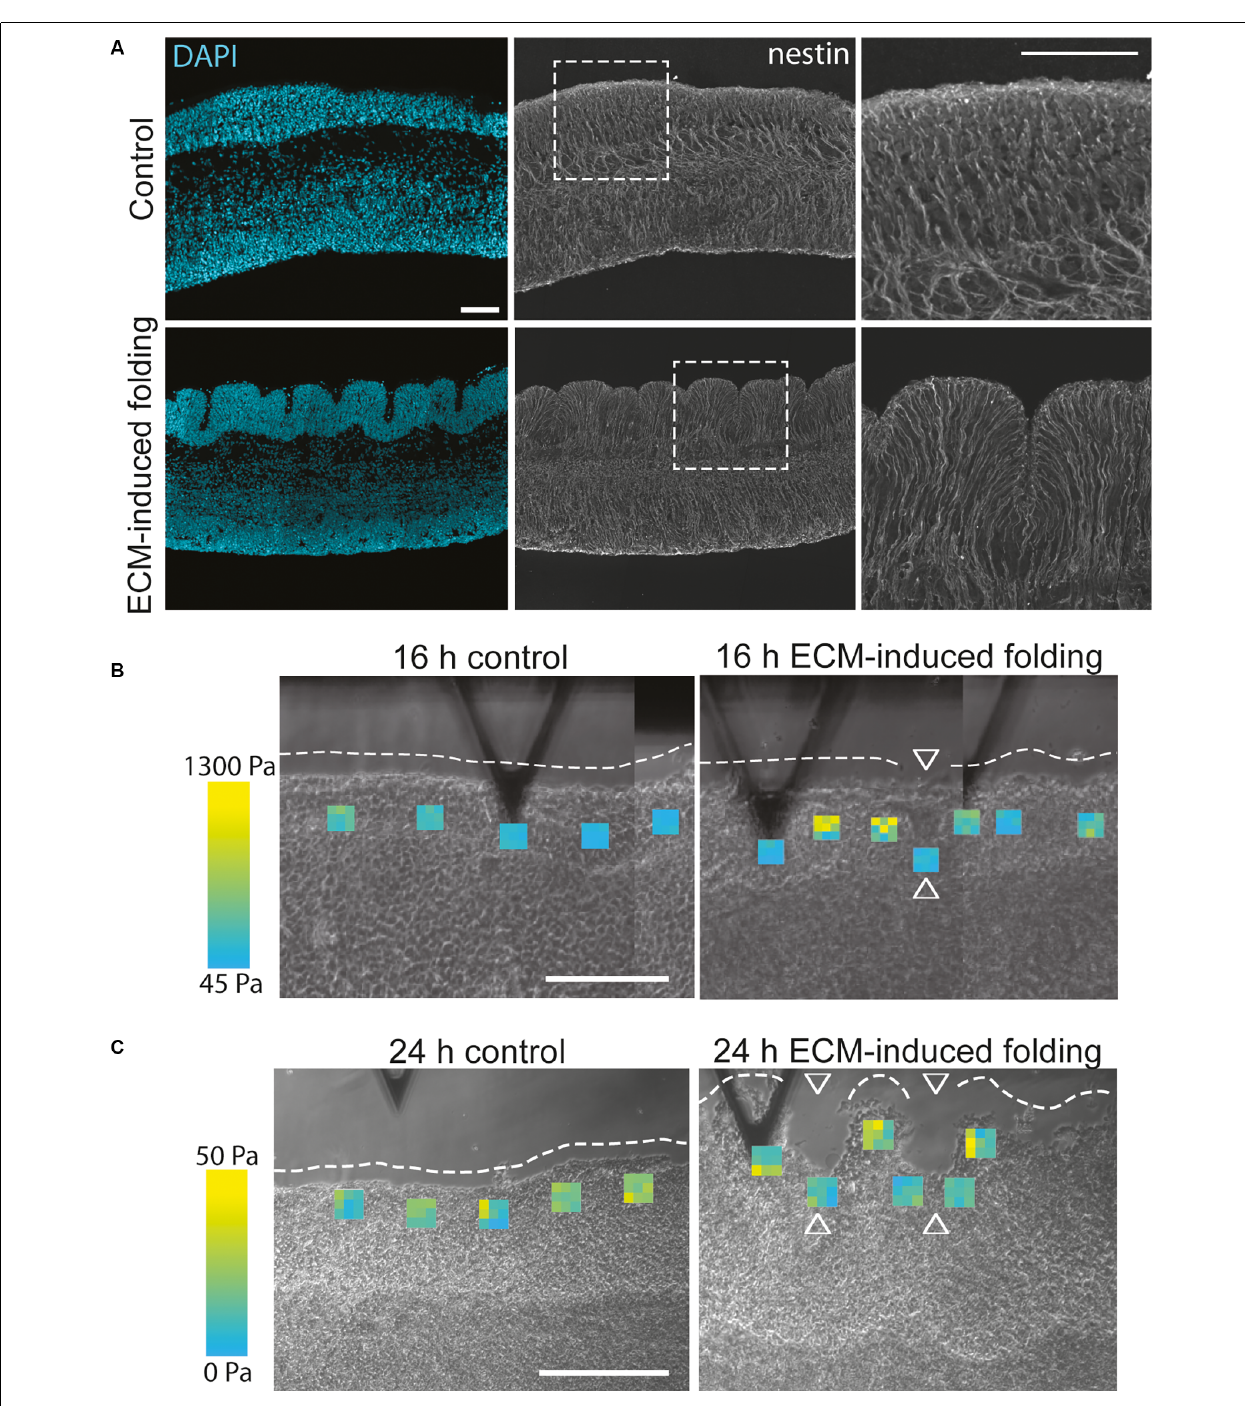
FIGURE 3 | ECM can induce folding and changes in ECM stiffness in human fetal neocortex ex vivo cultures. (A) Images showing a 13 gestation week (GW) human fetal neocortex after 24 h of ex vivo culture in the control condition (upper panels) or after the addition of the ECM components HAPLN1, lumican and collagen I (lower panels), with DAPI staining (blue) and immunofluorescence for the radial glial process marker nestin (grey). The addition of these ECM components induced the folding of the cortical plate. White dashed boxes delineate areas shown in the panels on the right. Scale bar represents 50 µ m. (B,C) Images showing atomic force microscopy of 13 GW human fetal neocortex after 16 h ( B , folding ongoing) or 24 h ( C , folding complete) of ex vivo culture in control conditions (left panels) or after the addition of the ECM components HAPLN1, lumican and collagen I (right panels, ECM-induced folding). Each heatmap square shows nine Young’s modulus values in the position the measurement was taken (see the range of values from blue (lowest) to yellow (highest)). White dashed lines outline the unfolded or folded CP surface; arrowheads indicate sulci. The stiffest measurements (yellow) are found in the forming gyri compared to the softer measurements (blue) in the forming sulci. Scale bar represents 200 µ m. Adapted from Long et al.